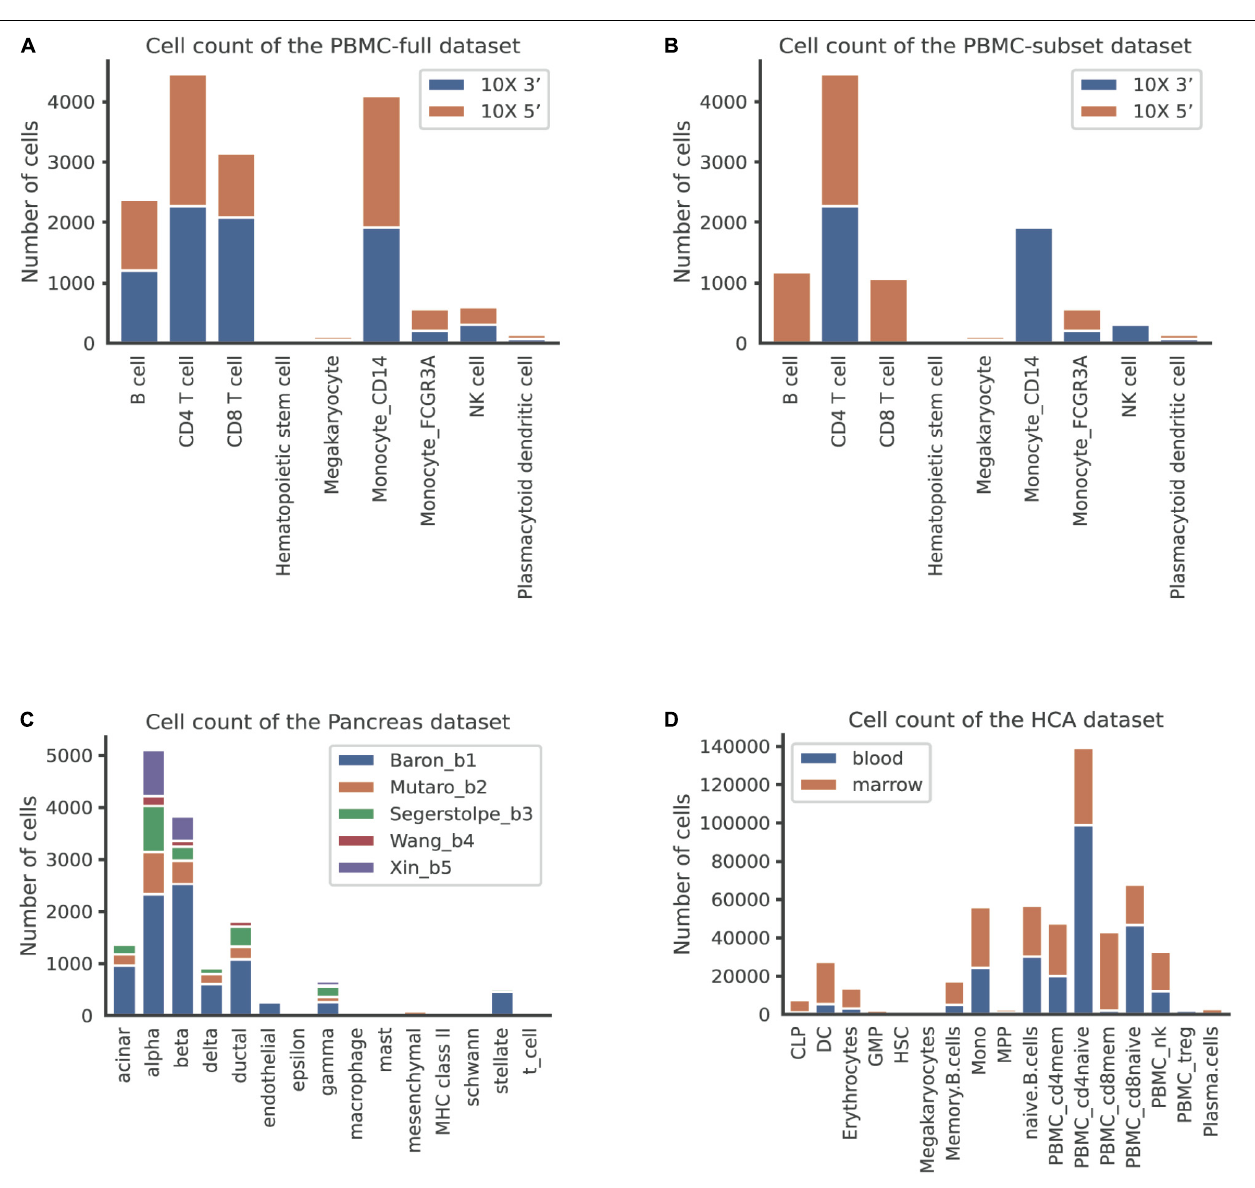
FIGURE 2 | The number of cells per cell type across batches in different datasets. (A) The human peripheral blood mononuclear cell (PBMC) full dataset, corresponding to the scenario of identical cell types. (B) The PBMC subset dataset, corresponding to the scenario of non-identical cell types. (C) The pancreas dataset, corresponding to the scenario of multiple batches. (D) The human cell atlas dataset, corresponding to the scenario of large-scale